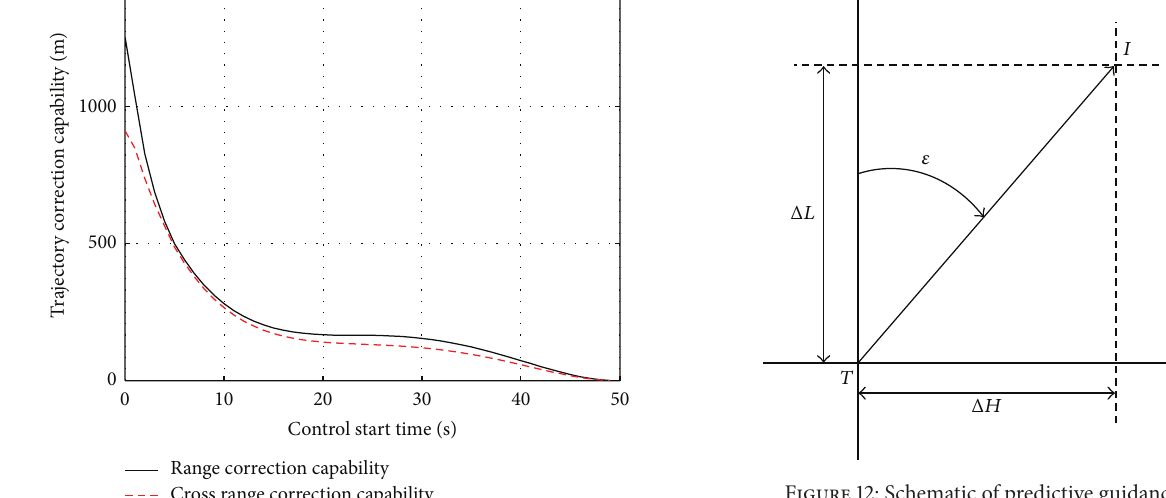
Figure 12: Schematic of predictive